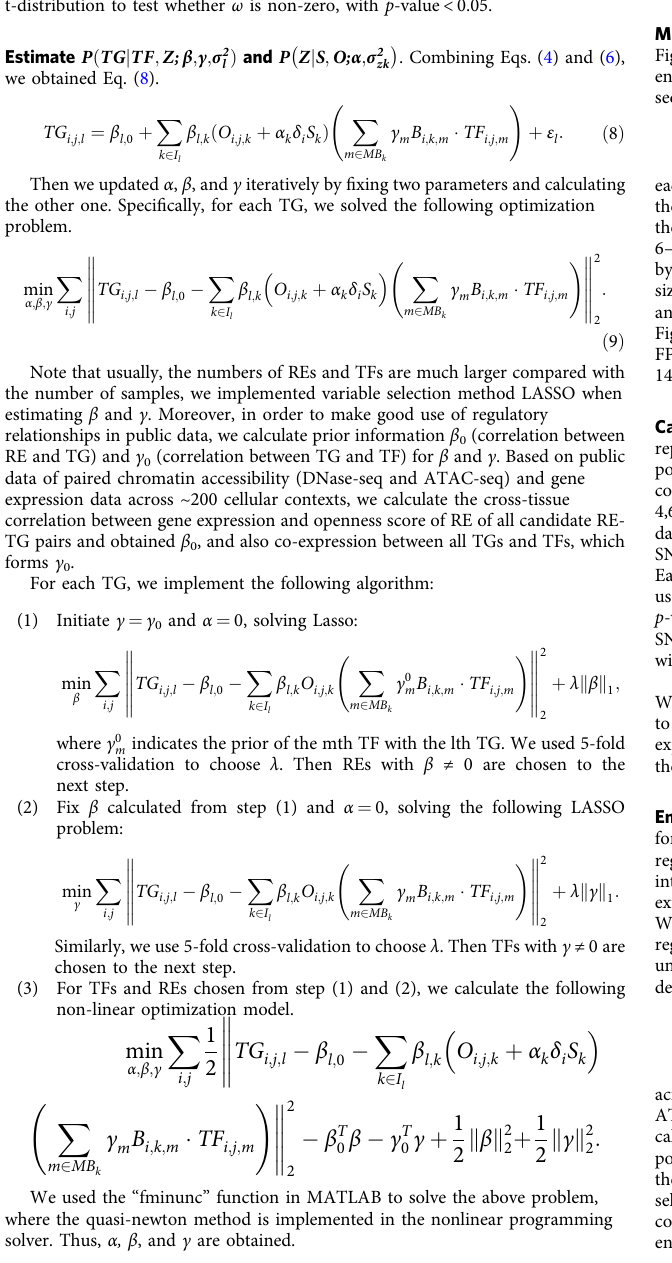
annotated regulatory regions such as enhancers and promoters in ENCODE. For each functional region set, we calculated the fold ratio by the formulation: where the whole-genome length is 3 billion base pairs and the number of total SNPs is 4,627,029 (Supplementary Fig. 4a). P -value is calculated using binomial distribution with distribution function b(x,n,p), where n = 111,182, p = Region length/whole-genome length, and x = #(Selection SNPs in